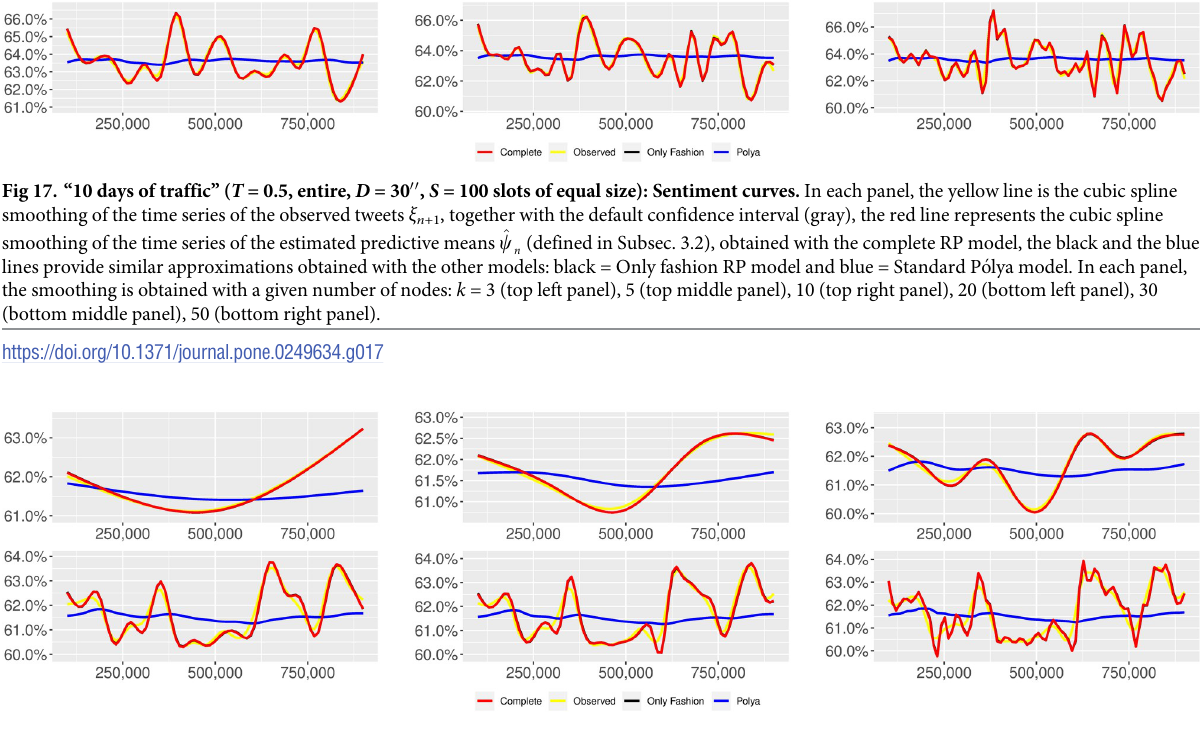
Fig 18. “10 days of traffic” ( T = 0, entire, D = 30 00 , S = 100 slots of equal size): Sentiment curves. In each panel, the yellow line is the cubic spline smoothing of the time series of the observed tweets ξ , together with the default confidence interval (gray), the red line represents the cubic spline n +1 smoothing of the time series of the estimated predictive means ^ c (defined in Subsec. 3.2), obtained with the complete RP model, the black and the blue n lines provide similar approximations obtained with the other models: black = Only fashion RP model and blue = Standard Po´lya model. In each panel, the smoothing is obtained with a given number of nodes: k = 3 (top left panel), 5 (top middle panel), 10 (top right panel), 20 (bottom left panel), 30 (bottom middle panel), 50 (bottom right panel).